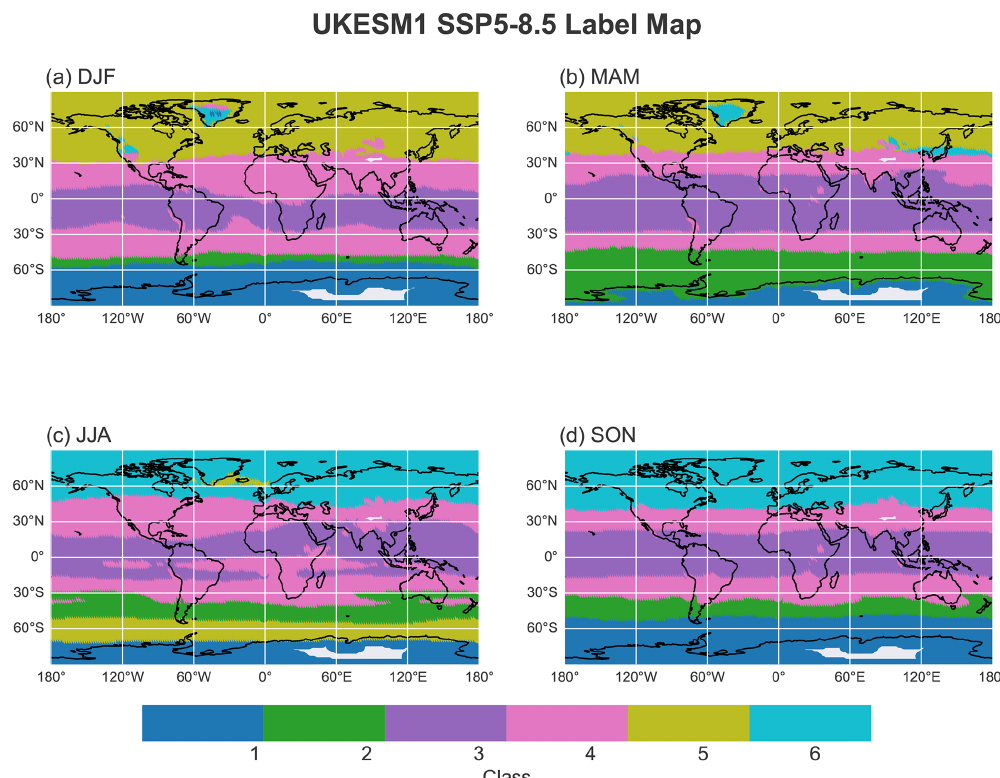
Figure 5. The same as Fig. 3 but for the SSP5.8-5 label map covering the years 2095–2100.